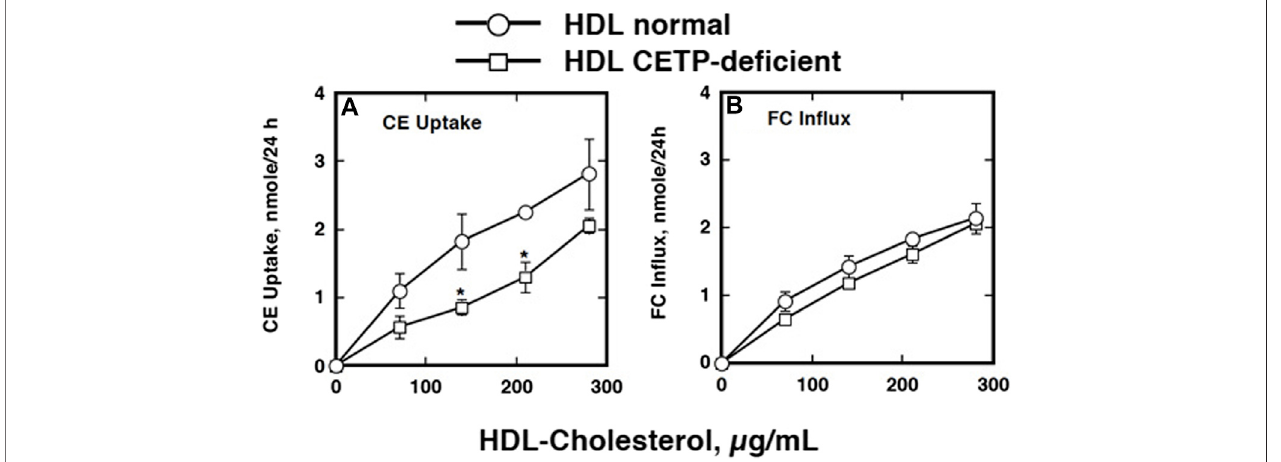
FIGURE 6 | Active CE uptake by the eggs of S. japonicum from normal HDL and that isolated from CETP de fi ciency (Okumura-Noji et al., 2001). HDL was labeled with [ 3 H]CE and active uptake was determined by the difference between the values at 37 ° C and 4 ° C. The data represent the average and SE of the triplicate assay. Symbolsareasfollows:circles,HDLpreparedfromnormalhumanplasma;squares,CETP-de fi cienthumanplasma.* p < 0.05betweennormalHDLandCETP-de fi cient HDL. Panel (A) , CE uptake. Panel (B) , FC in fl ux.